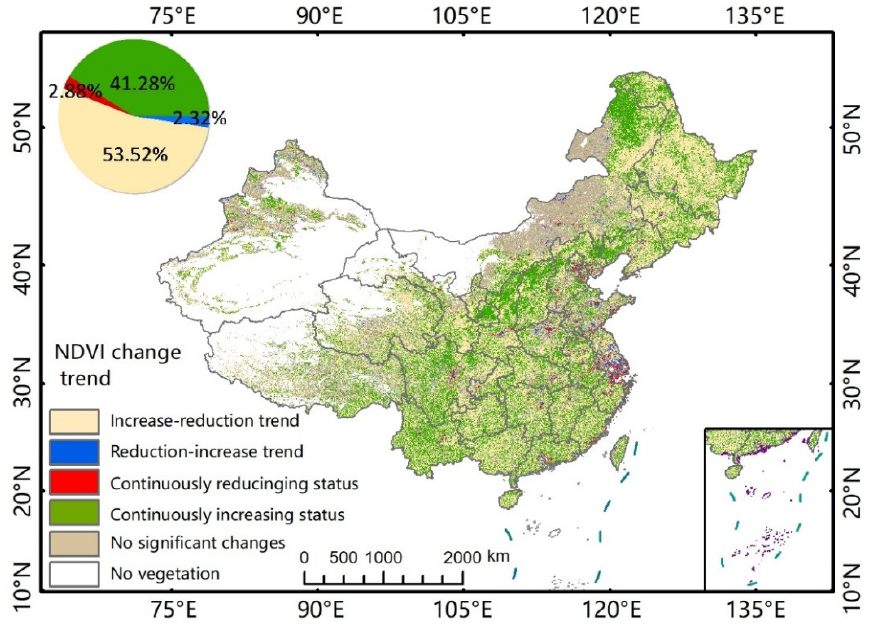
Figure 5. Vegetation variation sustainability in China.